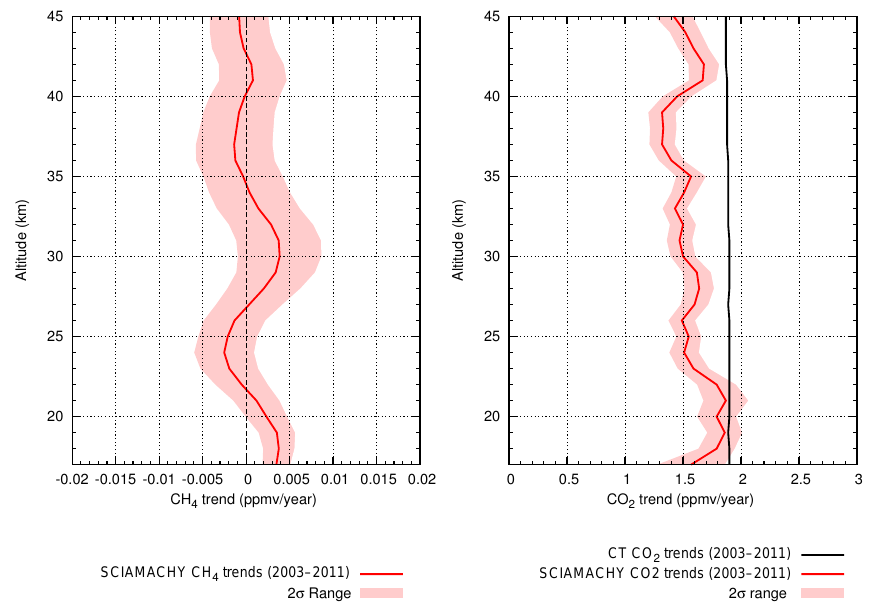
Figure 16. Calculated trends of CH 4 (left, red curve) and CO 2 (right, red curve) VMRs 2003 to 2011 as function of altitude. Shaded areas denote the 2 σ error range of the derived trends. For comparison, the corresponding trend derived from CarbonTracker CT2013 data is also shown in black. Note that the 2 σ range for CarbonTracker is smaller than the thickness of the trend line and therefore not visible in the